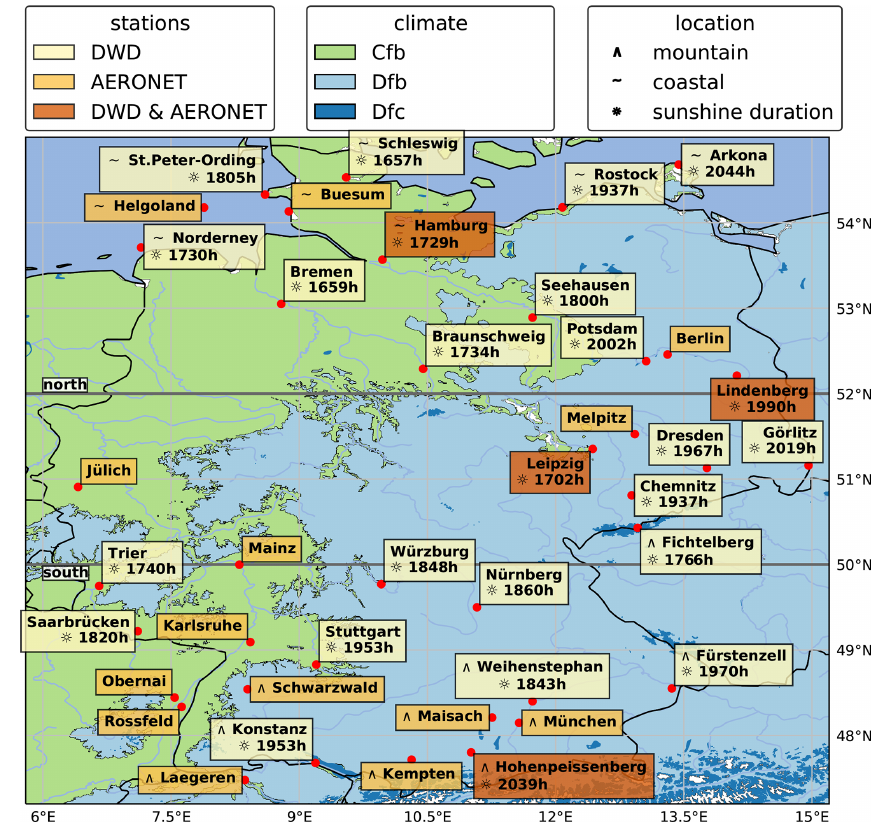
Figure 2. Map of Germany showing the locations of DWD and AERONET stations. The sunshine duration is calculated from the measured irradiance data at the DWD stations and shown as accumulated hours for the year 2015. On the map, location labels are indicated for mountain, coastal, northern and southern stations. The underlying map shows the Köppen–Geiger climate classification (Beck et al.,